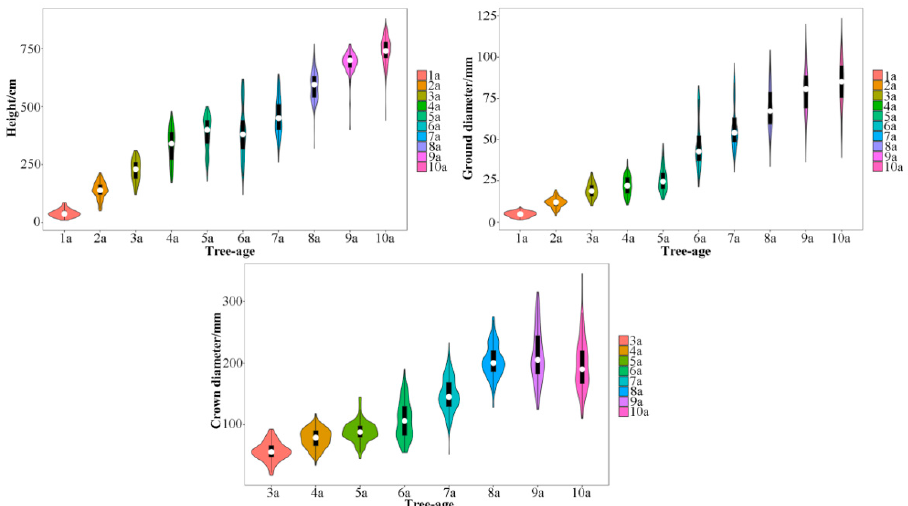
Figure 2. Distribution of growth traits of the Eucommia ulmoides F1 population for 10 consecutive years. The white dots in the middle represents the median value. The black rectangle in the middle represents 25th to 75th percentiles range. The middle vertical line extended from the black rectangle represents the 95% confidence interval. The vertical axis of the shape outside the black rectangle represents the data dispersion, and the horizontal axis represents the distribution frequency. 1a represents for 2010, 2a represents for 2011, and so on.